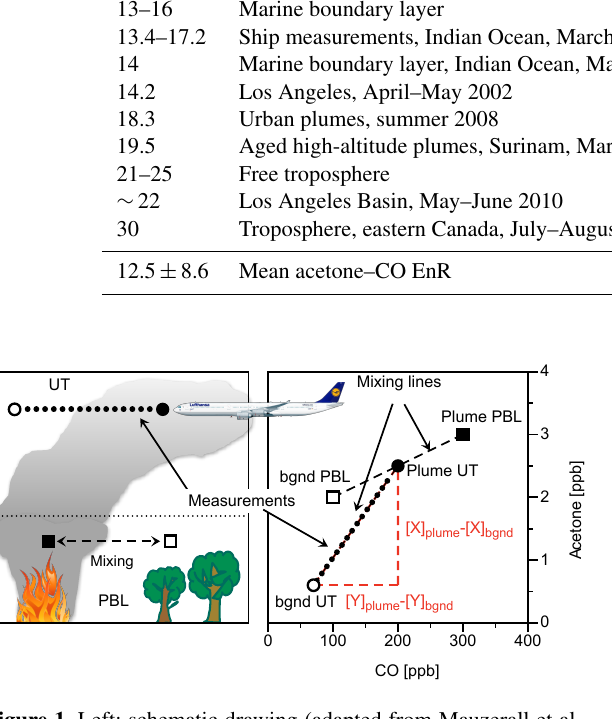
Figure 1. Left: schematic drawing (adapted from Mauzerall et al., 1998) of a biomass burning plume and its transport from the plane- tary boundary layer (PBL) into the upper troposphere (UT), where sampling takes place. Right: acetone plotted versus CO concentra- tions. Black-filled square (plume PBL): acetone–CO concentration in the fresh plume near the ground, which initially mixes with ad- jacent background (bgnd) air of the PBL (open square, bgnd PBL). When the resulting plume (full circle) rises into the upper tropo- sphere, the enhancement of acetone and CO are reduced as the plume mixes with background air of the UT (open circle, bgnd UT). In an ideal case, measured concentrations lie on the UT mixing line when the aircraft passes the plume. The slope of the mixing lines, equivalent to EnR (see Eq. 1), may differ considerably in the PBL and the